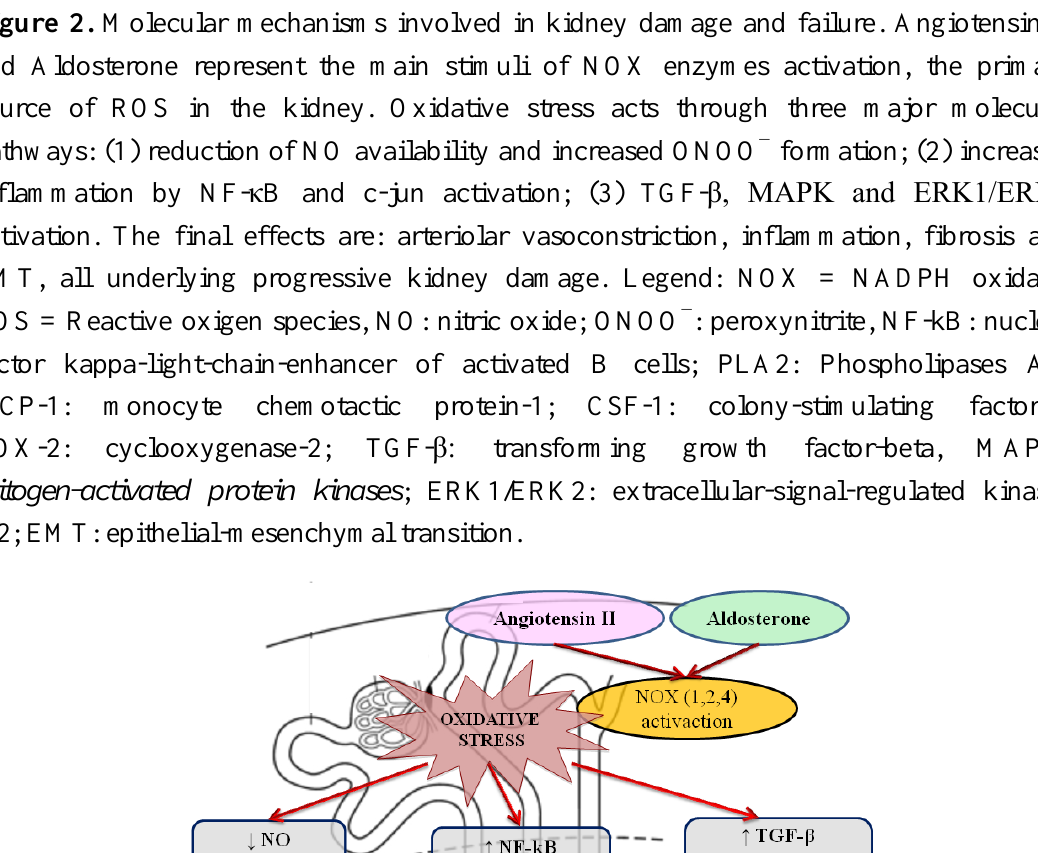
Figure 2. Molecular mechanisms involved in kidney damage and failure. Angiotensin II and Aldosterone represent the main stimuli of NOX enzymes activation, the primary source of ROS in the kidney. Oxidative stress acts through three major